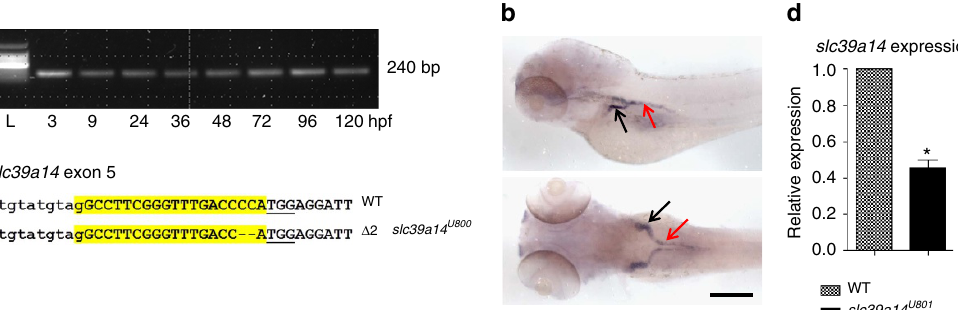
Figure 5 | Zebrafish slc39a14 is expressed during early zebrafish development and significantly reduced in s lc39a14 U801 mutants. ( a ) RT–PCR showing slc39a14 expression between 3 and 120 hpf in zebrafish. L, 100bp ladder (Promega). ( b ) Whole-mount in situ hybridization using a DIG-labelled antisense RNA probe showing slc39a14 expression in the proximal convoluted (black arrows) and straight (red arrows) pronephric tubules in zebrafish larvae at 4 dpf. Top, lateral view; bottom, dorsal view. Scale bar, 200 m m. ( c ) DNA sequence of the region within exon 5 of slc39a14 targeted by a CRISPR guide RNA is highlighted in yellow and the 2-bp deletion introduced in the s lc39a14 U801 mutant indicated by dashes. Pam sequence underlined. ( d ) qRT–PCR demonstrates a 2.2-fold reduction in slc39a14 expression in homozygous s lc39a14 U801 mutants (* P ¼ 0.0117). Primers were designed to detect all slc39a14 transcripts (Supplementary Table 4). Ef1 a was used as a reference gene. Data are presented as means ± s.d. from three independent experiments. Statistical analysis was performed using Student’s two-tailed t -test on individual D Ct values (* P o